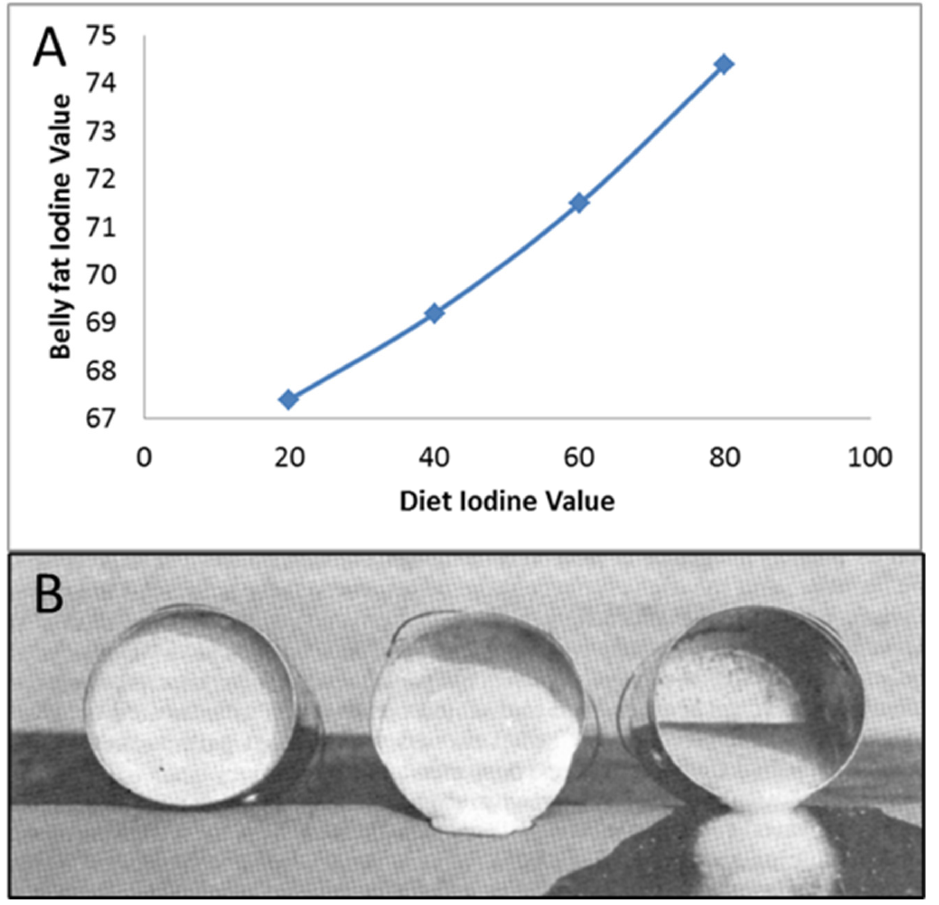
Figure 17. ( A ) Relationship between the fraction of unsaturated fatty acids in total fat in the diet, measured as the iodine value, and the fraction of unsaturated fat in belly fat [46]. ( B ) Pork belly fat at room temperature with low (left), medium (middle) and high iodine values (right) (image from Hankins, 1928, as used by Averette Gatlin, personal communication).